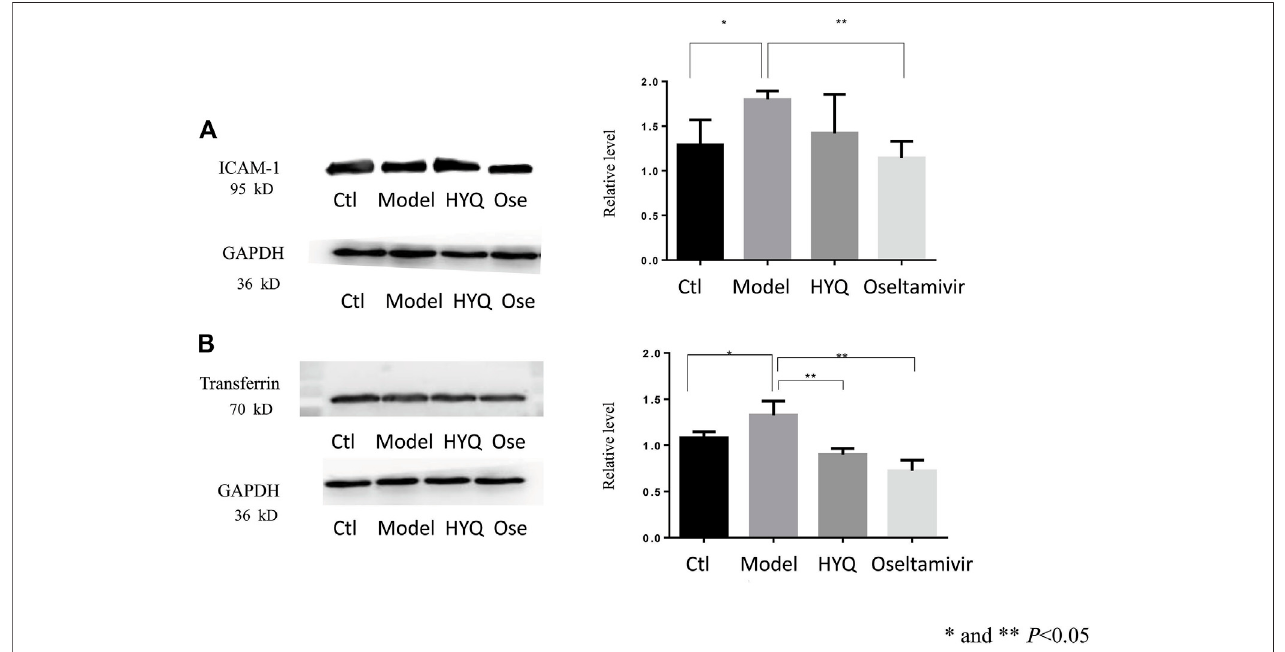
FIGURE5| Westernblotveri fi cationoffunctionalproteinsintheHYQ-mediatedeffectonviralpneumoniainmouselungsatthesixthdayafterinfection (A) Imageof ICAM-1 and its relative level among different groups (B) Image of transferrin and its relative level among different groups. Bar graphs are relative gray values to GAPDH. Three individual samples were analyzed in each group, and the results from each mouse were analyzed by one-way analysis of variance. ICAM-1: intercellular adhesion molecule-1. GAPDH: glyceraldehyde-3-phosphate dehydrogenase. Ctl: control. Ose: oseltamivir.